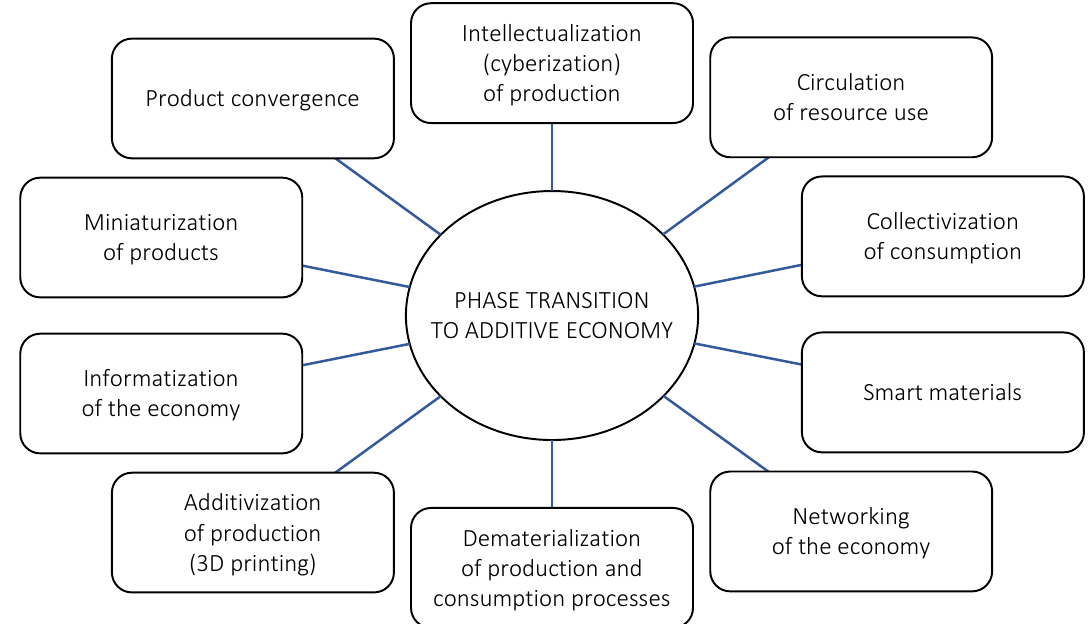
Figure 1. Components of transformations of phase transition to the additive